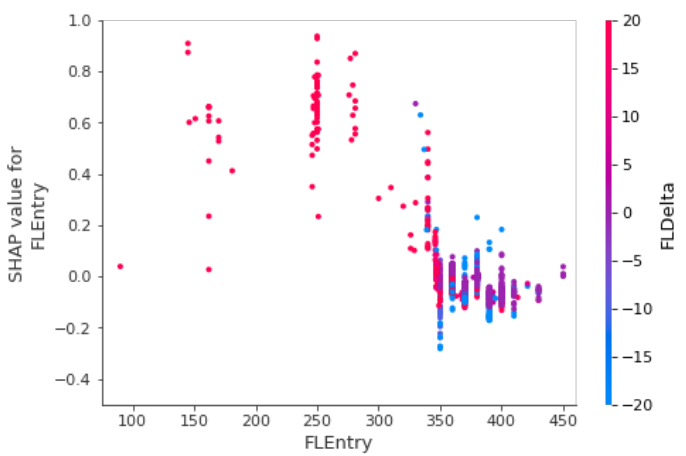
Figure 12. SHAP values (regression) of FLEntry according to FLDelta for Sector